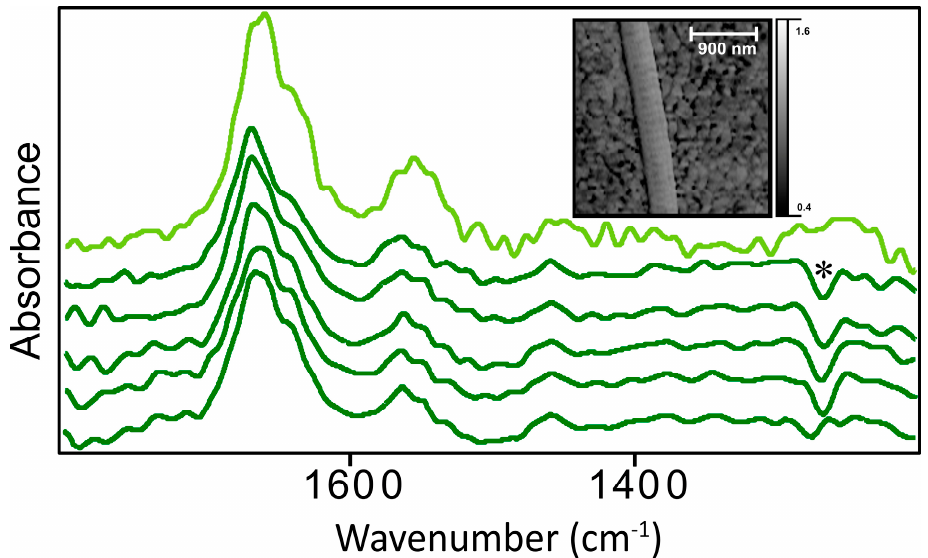
Figure 4. Nano-FTIR spectra of control tendon fibrils. Top light green spectrum is the average of 19 spectra acquired synchrotron light at the Advanced Light Source. Bottom five spectra (dark green) were acquired with a neaSNOM microscope (neaspec GmbH, Munich-Haar, Germany). Asterisk (*) at 1265 cm − 1 shows negative peak due to polydimethylsiloxane (PDMS) contamination of the AFM tip. Inserted AFM image shows a typical control fibril, lying on sputtered Au surface, with D-banding; scale bar = 900 nm.